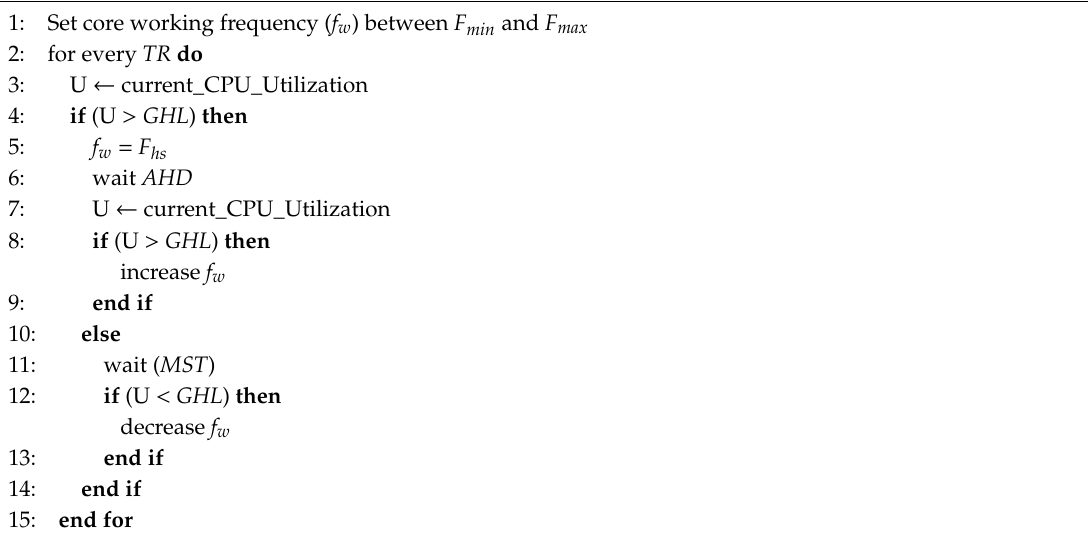
Algorithm 1 Interactive governor